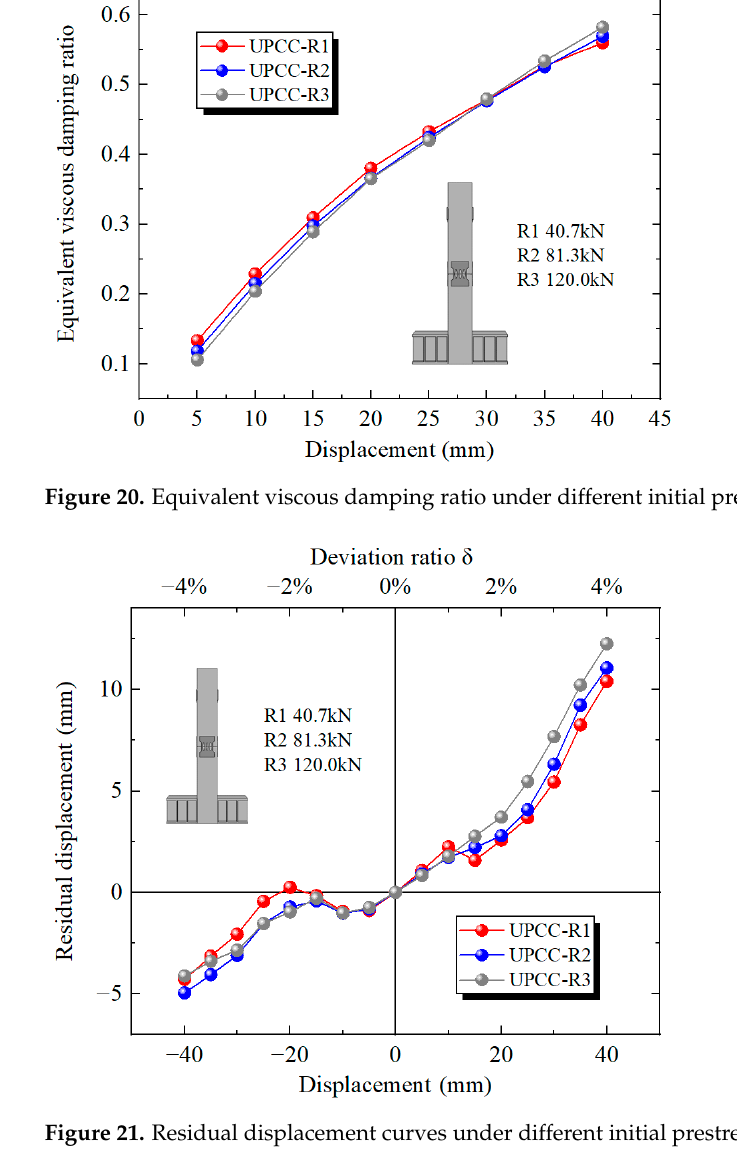
prestress has little effect on the equivalent stiffness of the